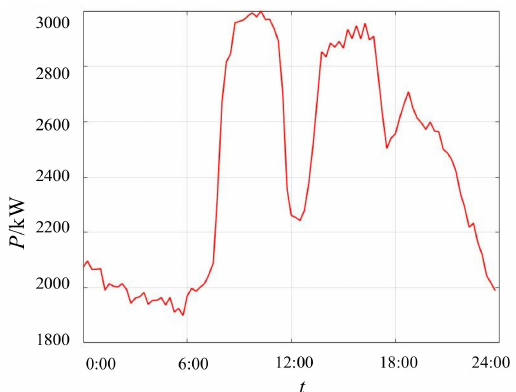
Figure A1. The curve of daily load comes from the data of bus load measured by a substation in